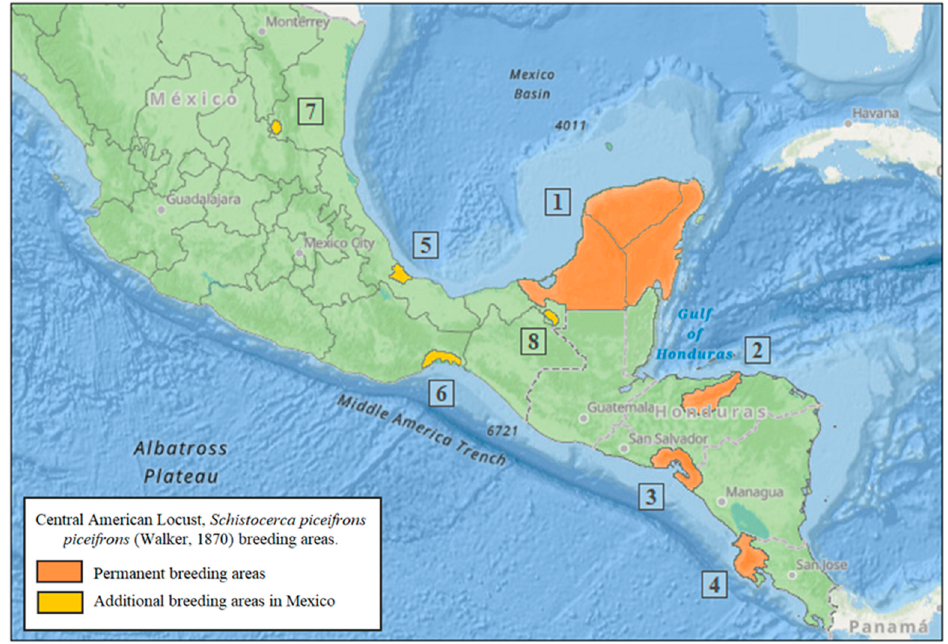
Figure 1. Central American locust, Schistocerca piceifrons piceifrons (Walker, 1870), permanent breeding areas: (1) Yucatán Península, México, (2) Valley of Rio Aguan, Northern Honduras, (3) Gulf of Fonseca in El Salvador, Honduras, and Nicaragua, (4) Province of Guanacaste, Costa Rica, (5) State of Veracruz, México, (6) Chahuites-Tepanatepec, on the limits of Oaxaca and Chiapas, Mexico, (7) Border of San Luis Potosí-Tamaulipas states, México, and (8) Tabasco, on the banks of the Usumacinta River, border with Guatemala.